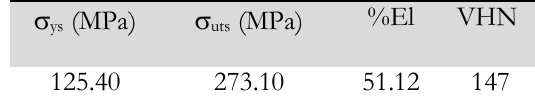
Table.2 Mechanical properties of the interstitial free steel used in the